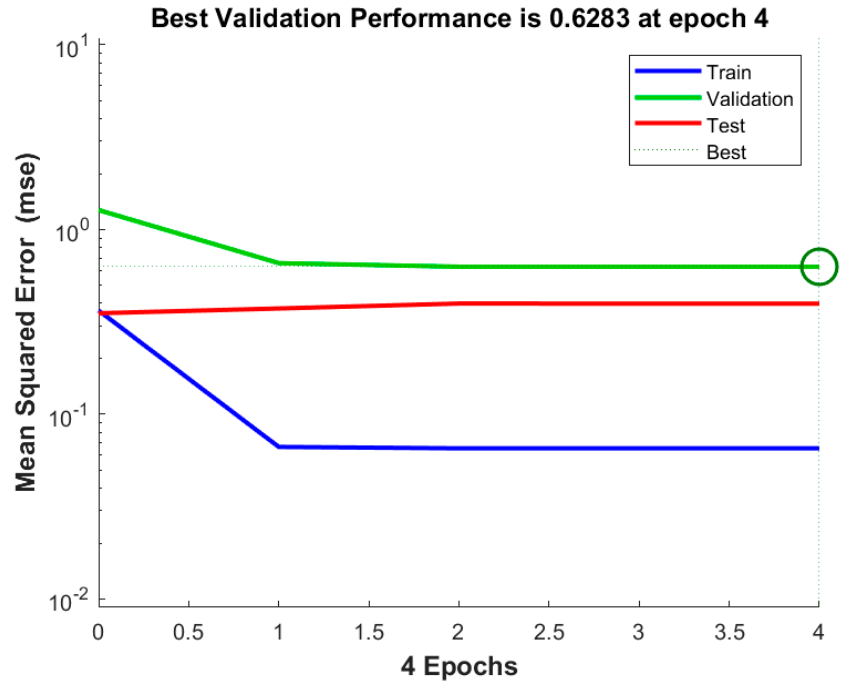
Figure 11. Plot of validation performance by MSE.